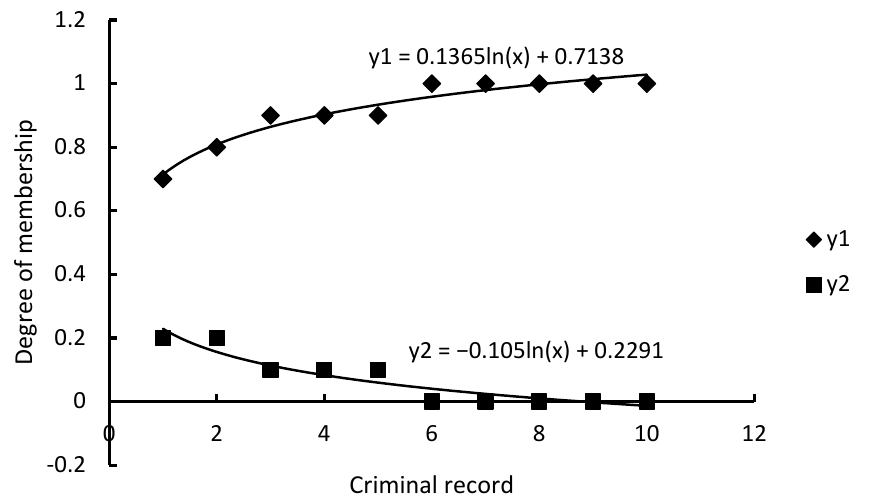
Figure A23. Single factor evaluation for the index of criminal record (one and more times).